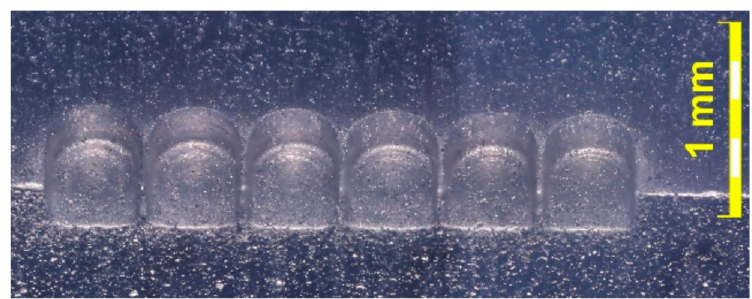
Figure 20. Cavities machined for tests of repeatability [33].